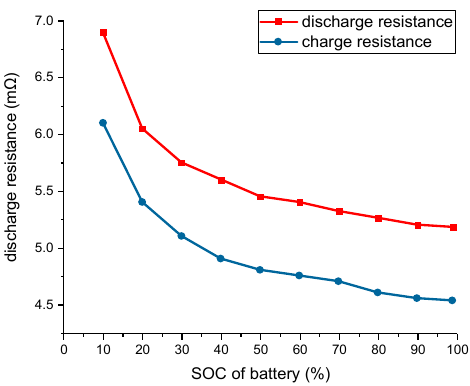
Figure 5. Charge and discharge resistances of the LiFePO 4 cell at room temperature of 25 °C.